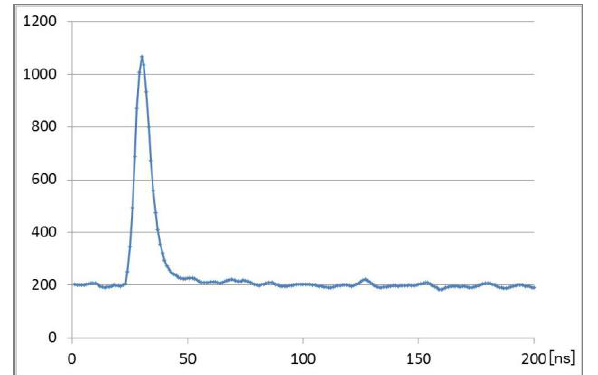
Figure 8. Waveform of Sudajii (single points with